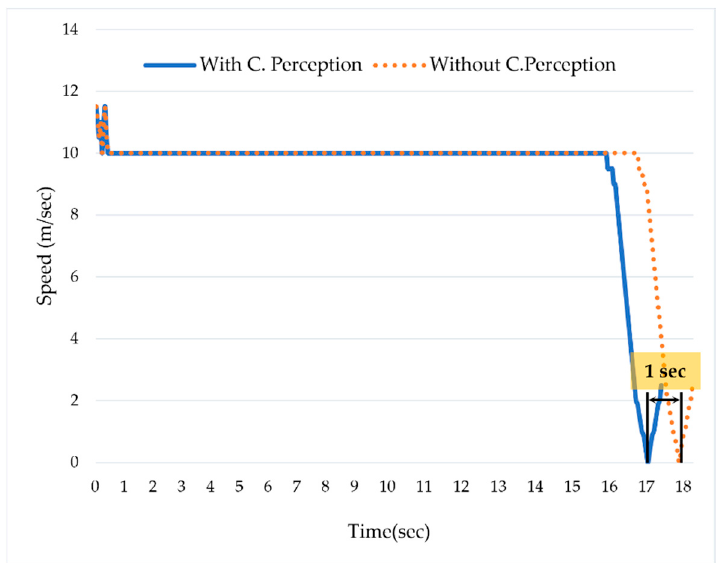
Figure 7. The behavior of an ADS with and without collaborative perception.